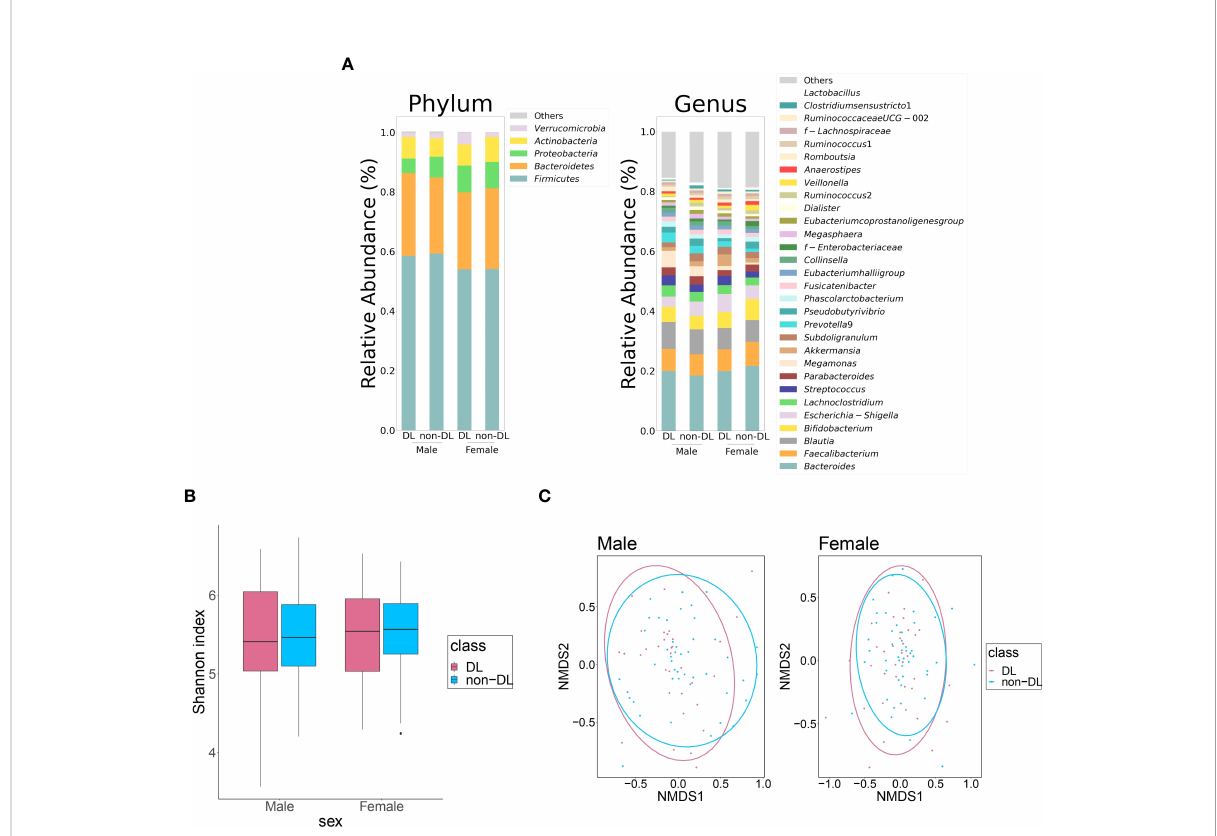
FIGURE 2 Differences in the gut microbiota between DL and non-DL groups. (A) Comparison of relative abundance ratios at the phylum and genus level for the top 30 bacterial genera with mean abundance ratios according to the presence or absence of DL. (B) Differences in the a -diversity calculated using Shannon index, 5,000 depths. One sample that failed to be sequenced were excluded. (Men: P = 0.922, Women: P = 0.559, Quade ’ s non-parametric ANCOVA) (C) Plot of the b -diversity analysis calculated by NMDS ordination based on Bray-Curtis distance matrix. Red: DL group; blue: non-DL group. Ellipses represent the 95% con fi dence interval for each genus in the analysis. (Men: P = 0.422, Women: P = 0.407,